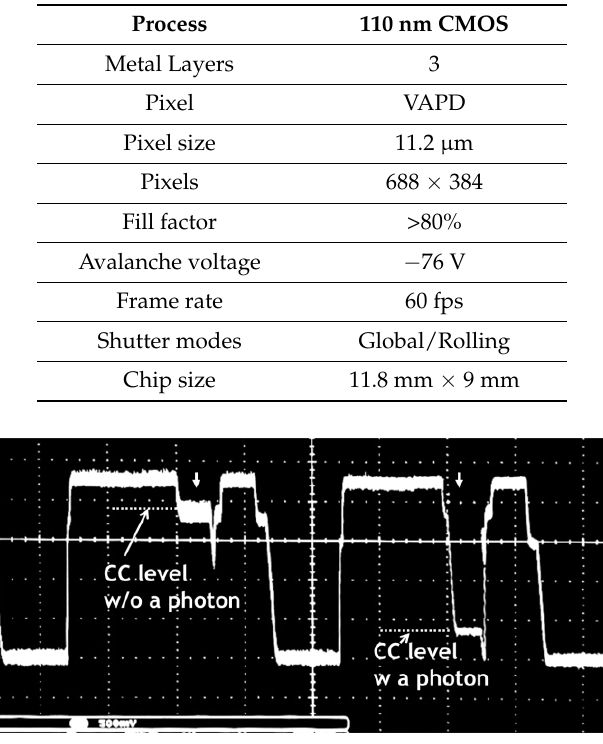
Figure 11. A response of VAPD outputs with and without photon detection measured at CC node. The difference of the two levels corresponding to one photon is about 1.2 V. Note the finest voltage scale is 500 mV. Table 2. Specification of a developed TOF-CIS.